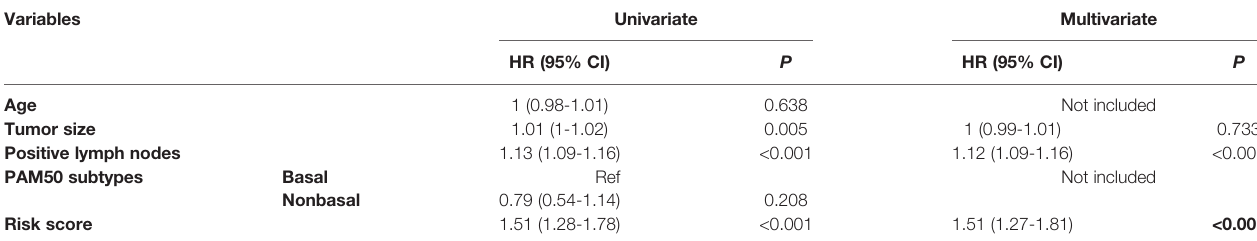
TABLE 3 | HRs and P values of the covariates in the univariate and multivariate Cox proportional hazards model for the risk score. Variables